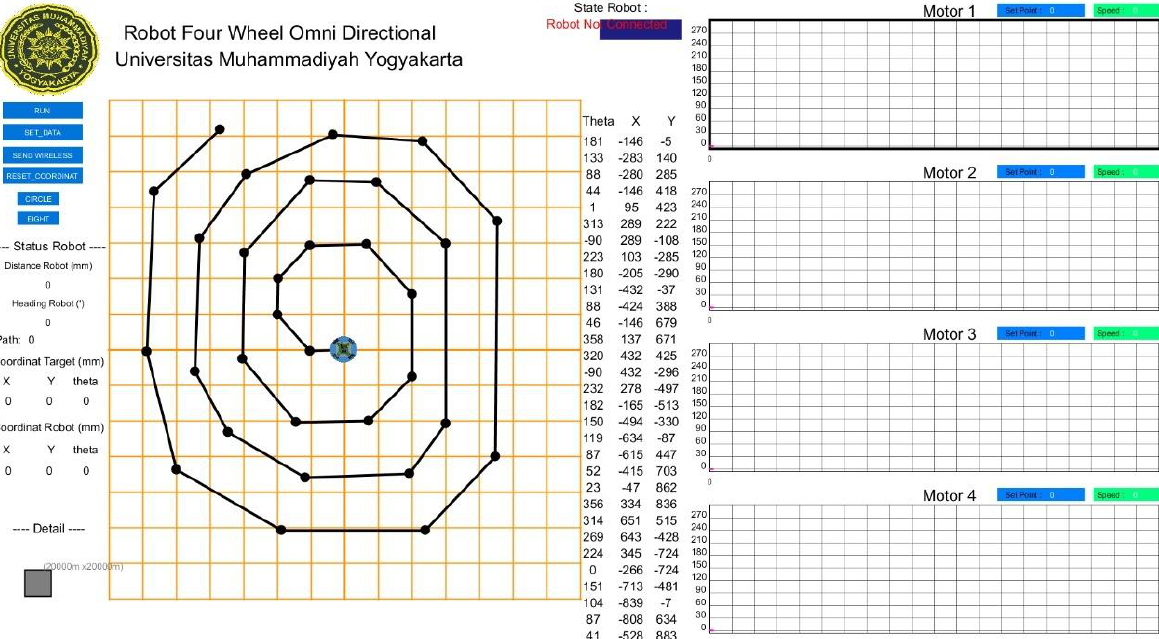
Figure 4. Graphical User Interface of the Omnidirectional